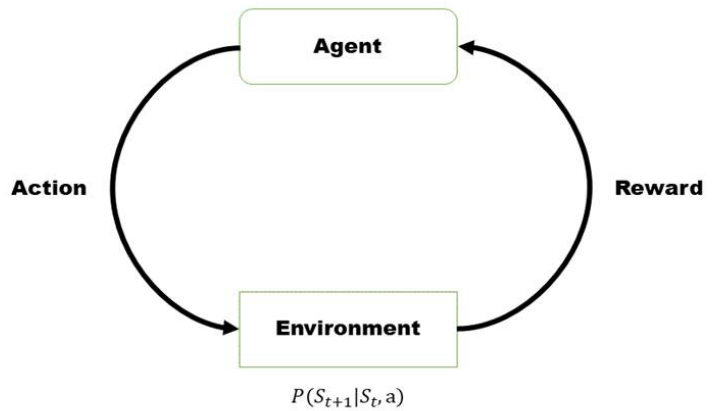
Figure 1. Basic framework of reinforcement learning.